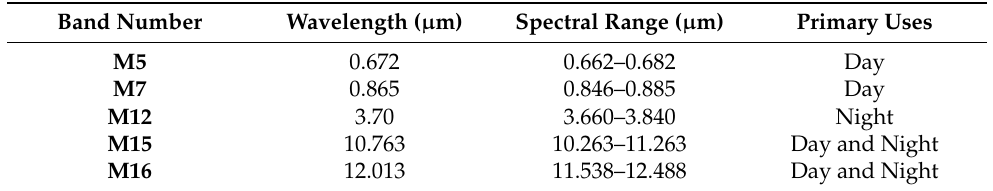
Table 2. Summary of the VIIRS bands used in the FCDN_CSM